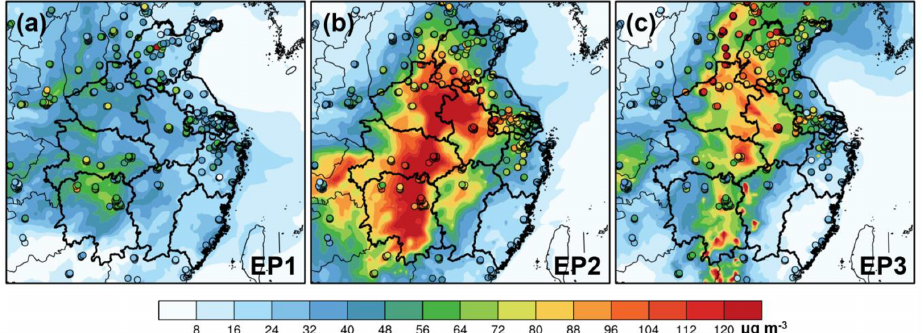
Figure 4. Spatial distributions of simulated and observed episode-averaged PM 2 . 5 concentrations over CEC during (a) EP1, (b) EP2, and (c) EP3. Colored circles denote locations of ground measurement sites and corresponding values. The maps were created by NCAR Command Language (NCL) (http://www.ncl.ucar.edu/, last access: 18 December 2019).